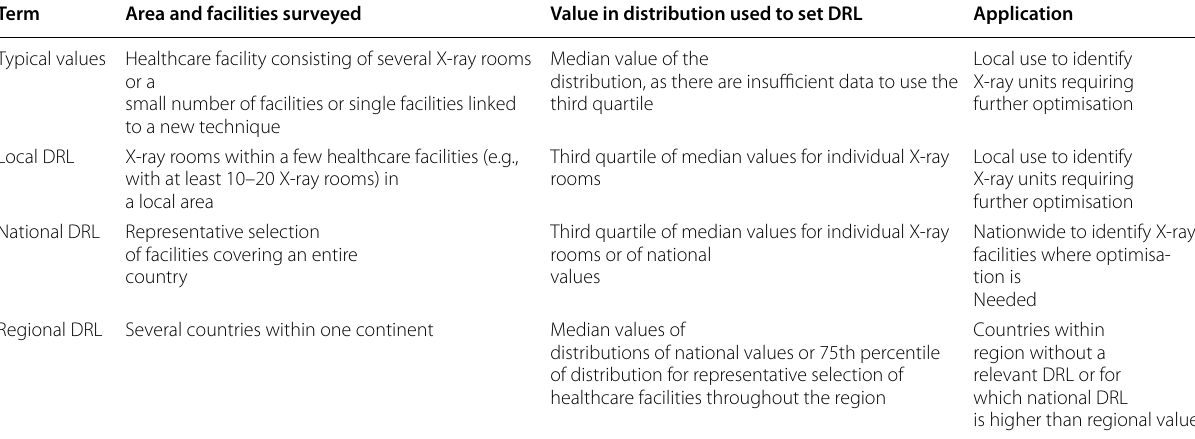
Table 1 Types of diagnostic reference levels (DRLs), methods of derivation, and areas of application (from ICRP-135 [1])